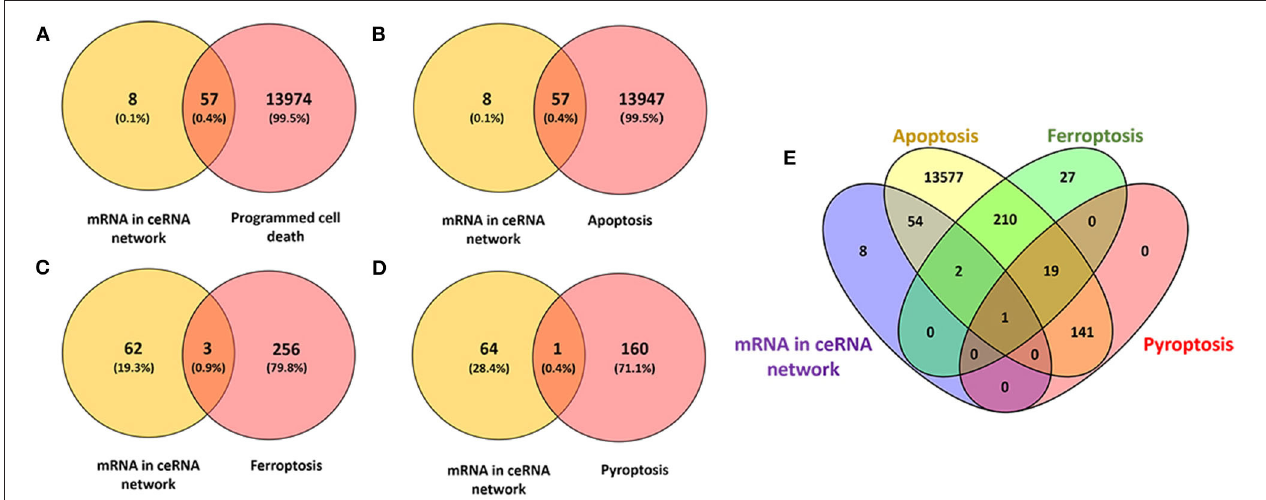
FIGURE 5 | Identification of the candidate programmed cell death related genes in the ceRNA networks. (A) Venn diagram to identify common mRNAs between differentially expressed mRNAs in our ceRNA networks and programmed cell death related mRNAs; (B) Venn diagram to identify common mRNAs between differentially expressed mRNAs in our ceRNA networks and apoptosis related mRNAs; (C) Venn diagram to identify common mRNAs between differentially expressed mRNAs in our ceRNA networks and ferroptosis related mRNAs; (D) Venn diagram to identify common mRNAs between differentially expressed mRNAs in our ceRNA networks and pyroptosis related mRNAs; (E) Interactions between differentially expressed mRNAs in our ceRNA networks and apoptosis, ferroptosis, pyroptosis related